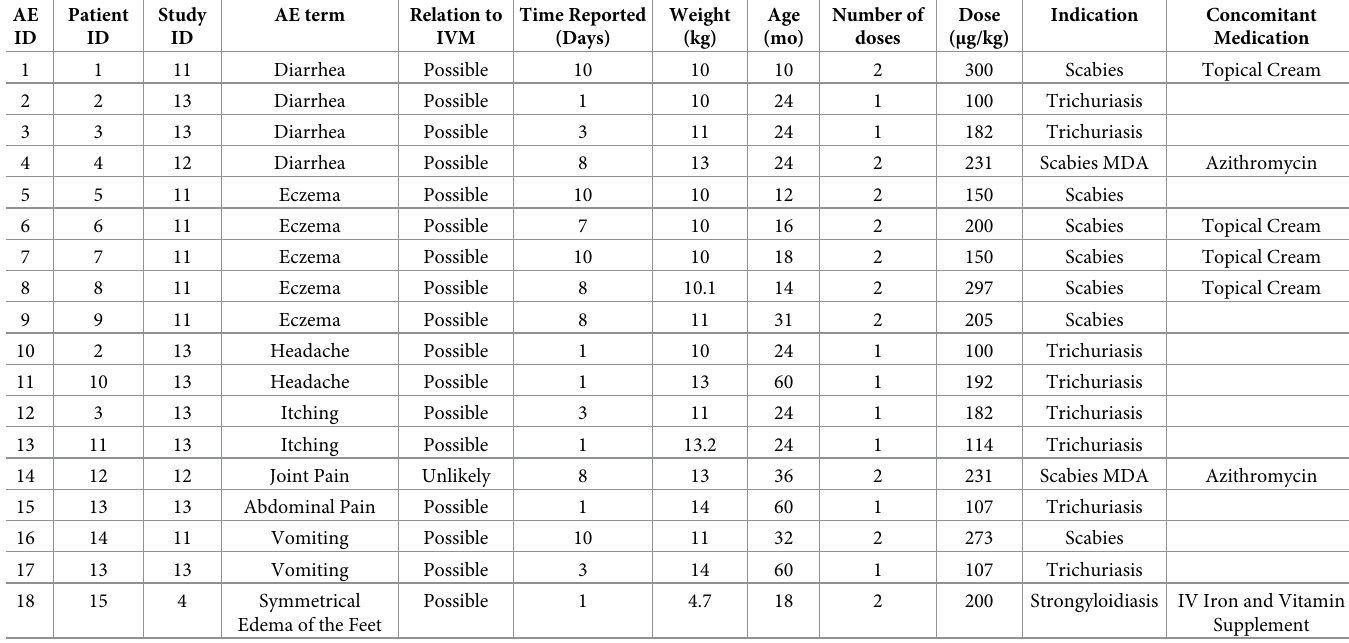
Table 2. Listing of individual adverse events (n = 18) following ivermectin ingestion. None of the AEs were classified as serious adverse